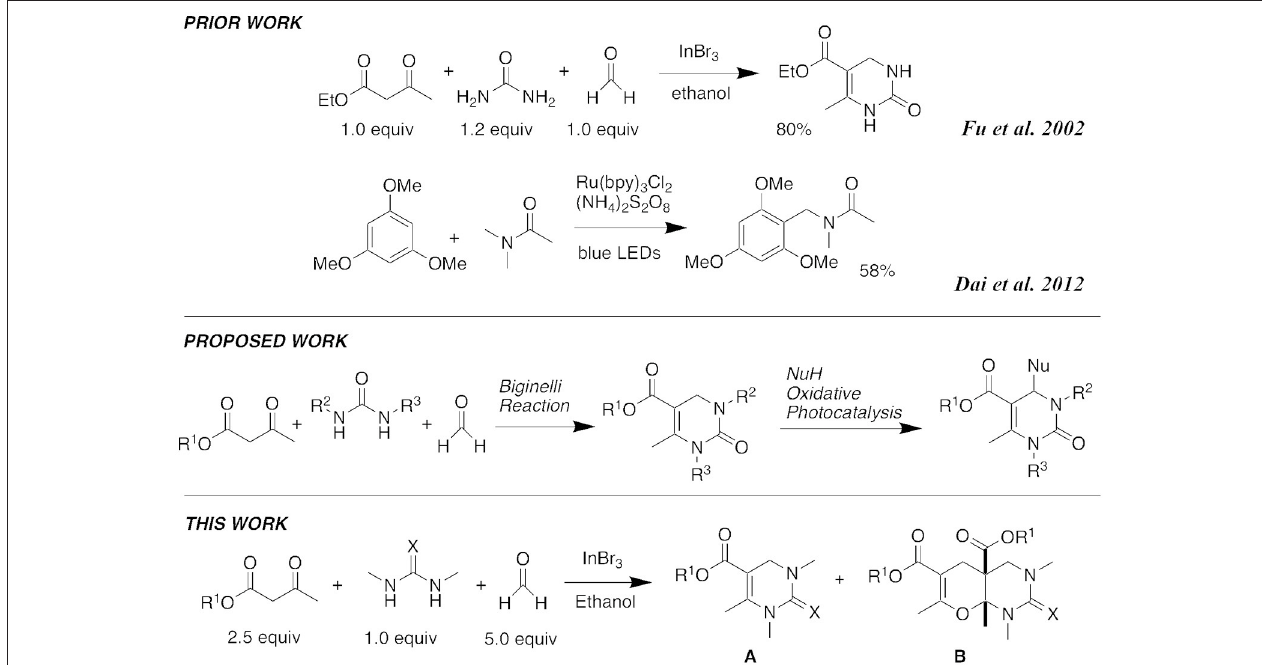
FIGURE 2 | Literature precedence and synthetic plans.